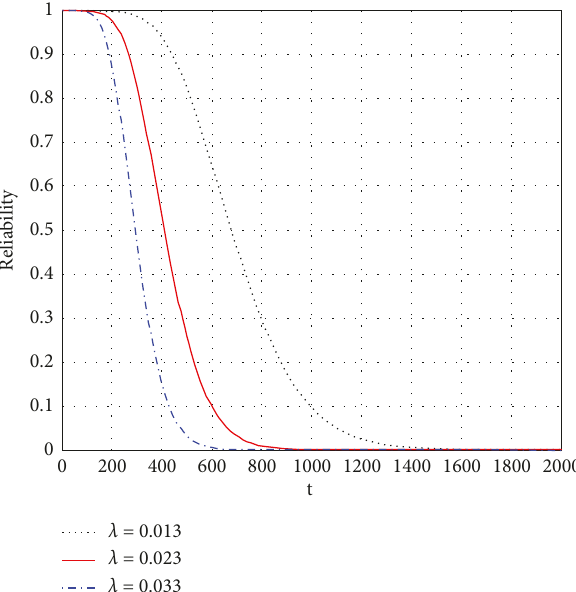
Figure 19: Sensitivity analysis of R ( t ) on λ